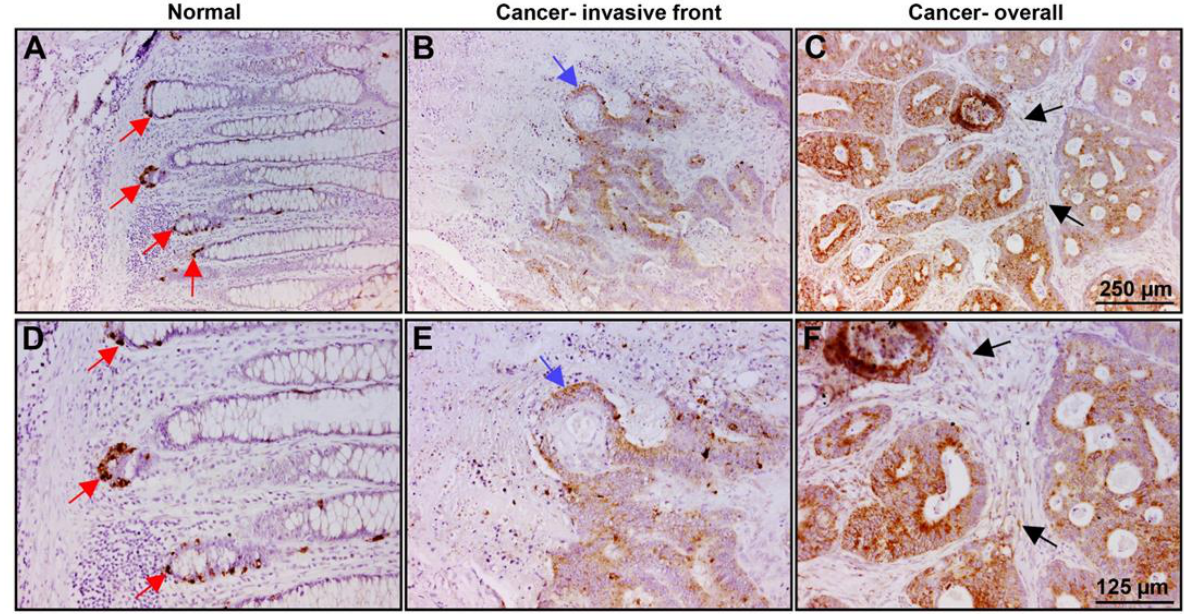
Figure 6. PLOD2 is localized in the stem cell compartment of the normal mucosa and at increased levels in the invasive front and throughout the CRC tissue. Samples of CRC tissue from 38 patients were paraffin-fixed and immunostained with an antibody against PLOD2. ( A , D ) PLOD2 is expressed in the stem cell compartment at the bottom of the crypts (red arrows) in the normal mucosa. ( B , E ) PLOD2 is localized at the invasive front of the CRC tissue (blue arrow). ( C , F ) In some tumors, PLOD2 is also expressed at increased levels throughout the tumor tissue, with a weak signal in the stromal tissue around the tumor (black arrows).